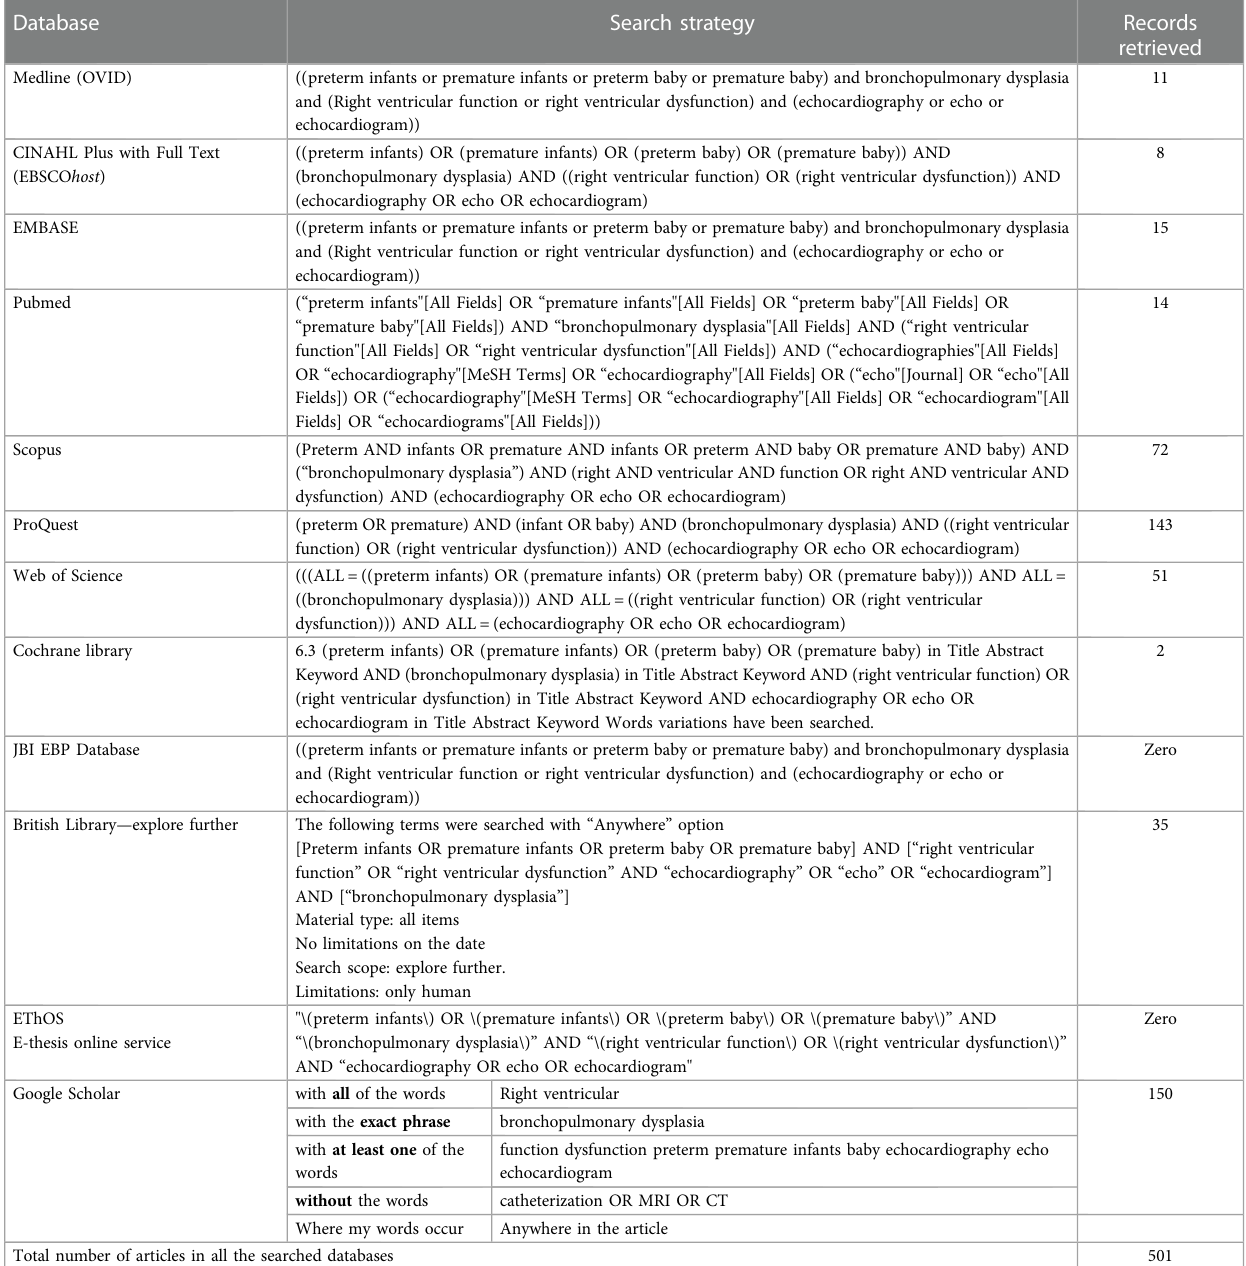
TABLE 1 Search strategies. (Search completed on the 02nd of April 2022).